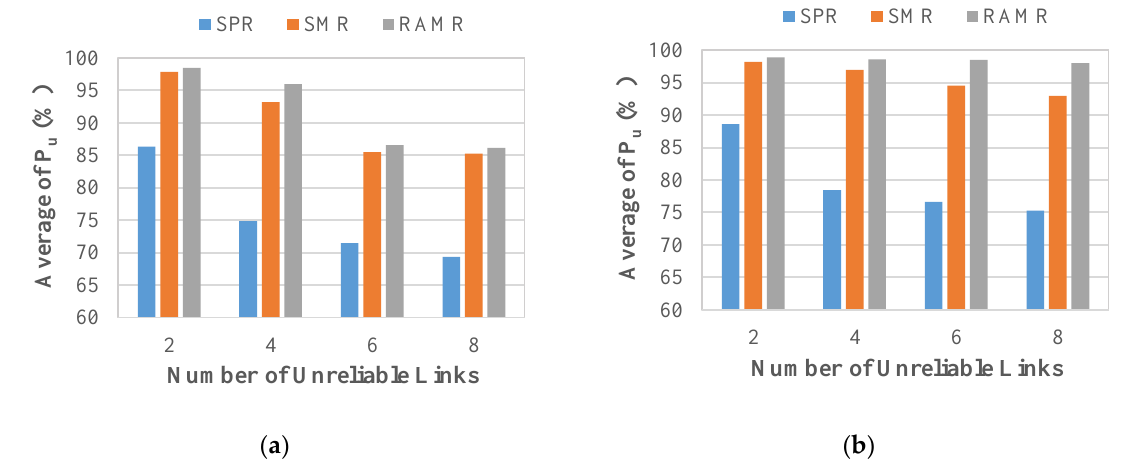
Figure 12. Reliabilities in different topologies when the number of unreliable links n varies from 2 to 8. ( a ) Reliabilities in Topology 2; ( b ) Reliabilities in Topology 3.